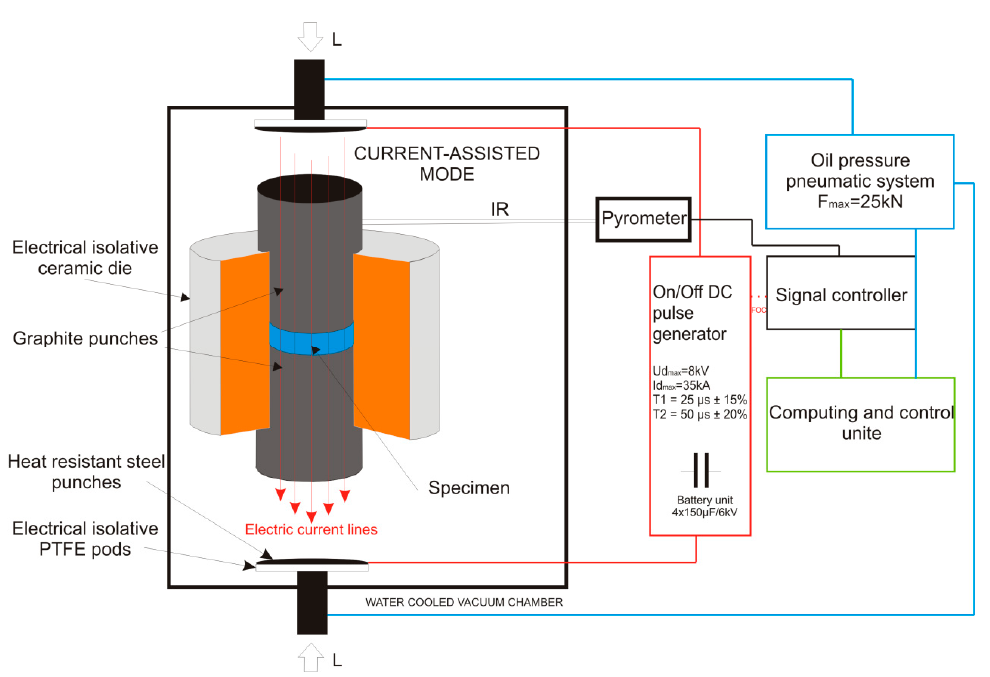
Figure 1. Schematic arrangement of the isolative die setup for a Pulse Plasma Sintering Press module.